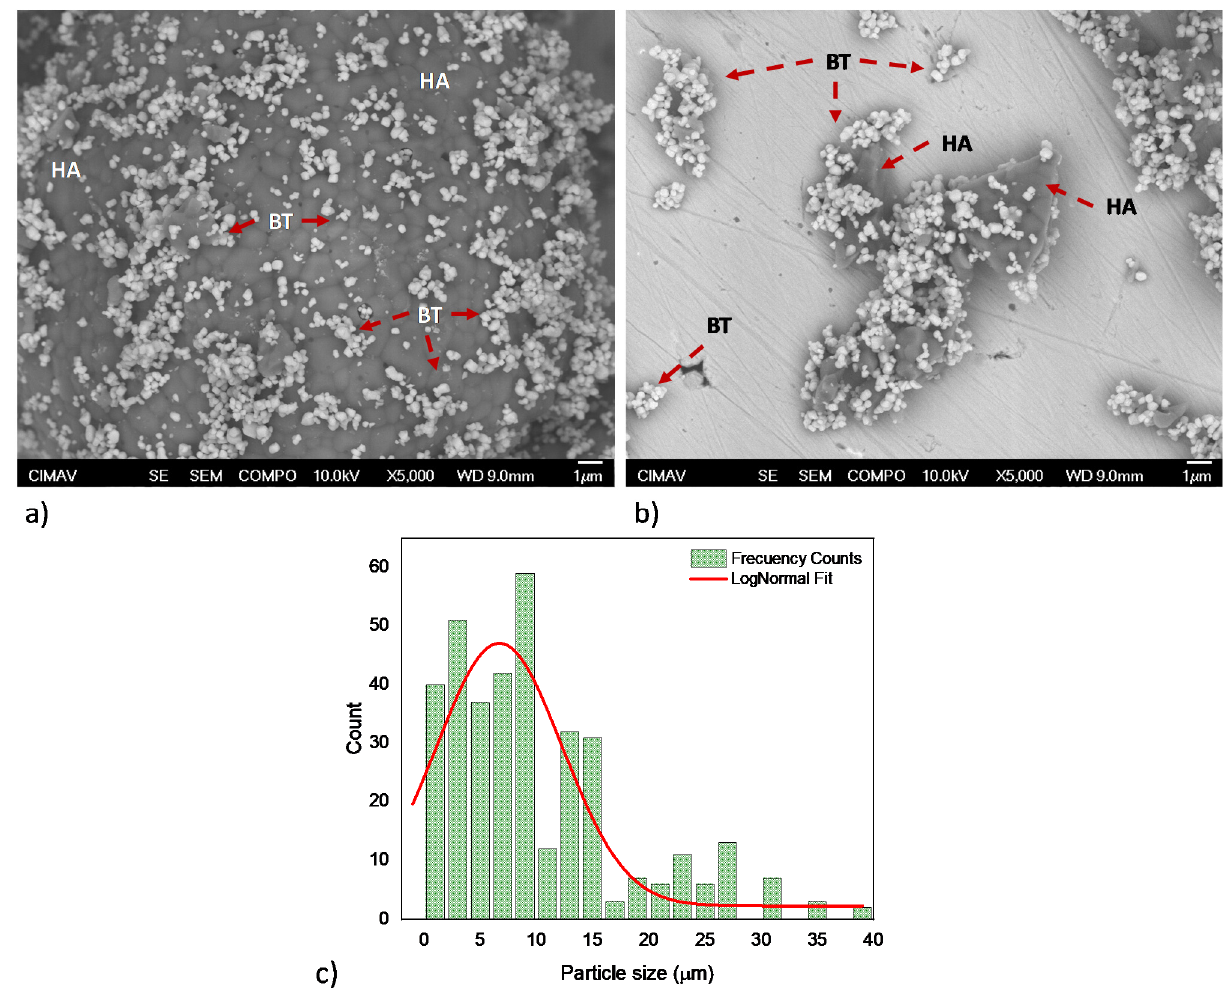
Figure 2. HA/BT feedstock FE-SEM micrographs; ( a ) powder processing by MSH, and ( b , c ) powders processing by HEBM and their respective histogram.